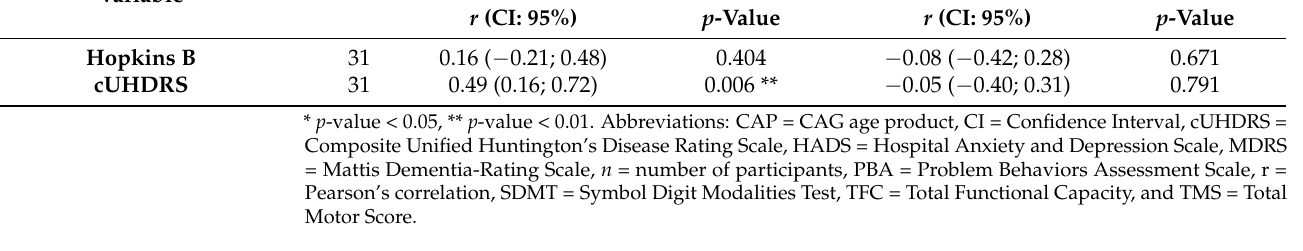
Table A3. Relationships between SRSQ domains and repeated clinical measures in